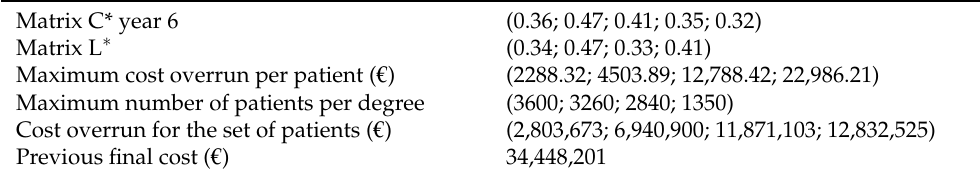
Table 10. Final cost